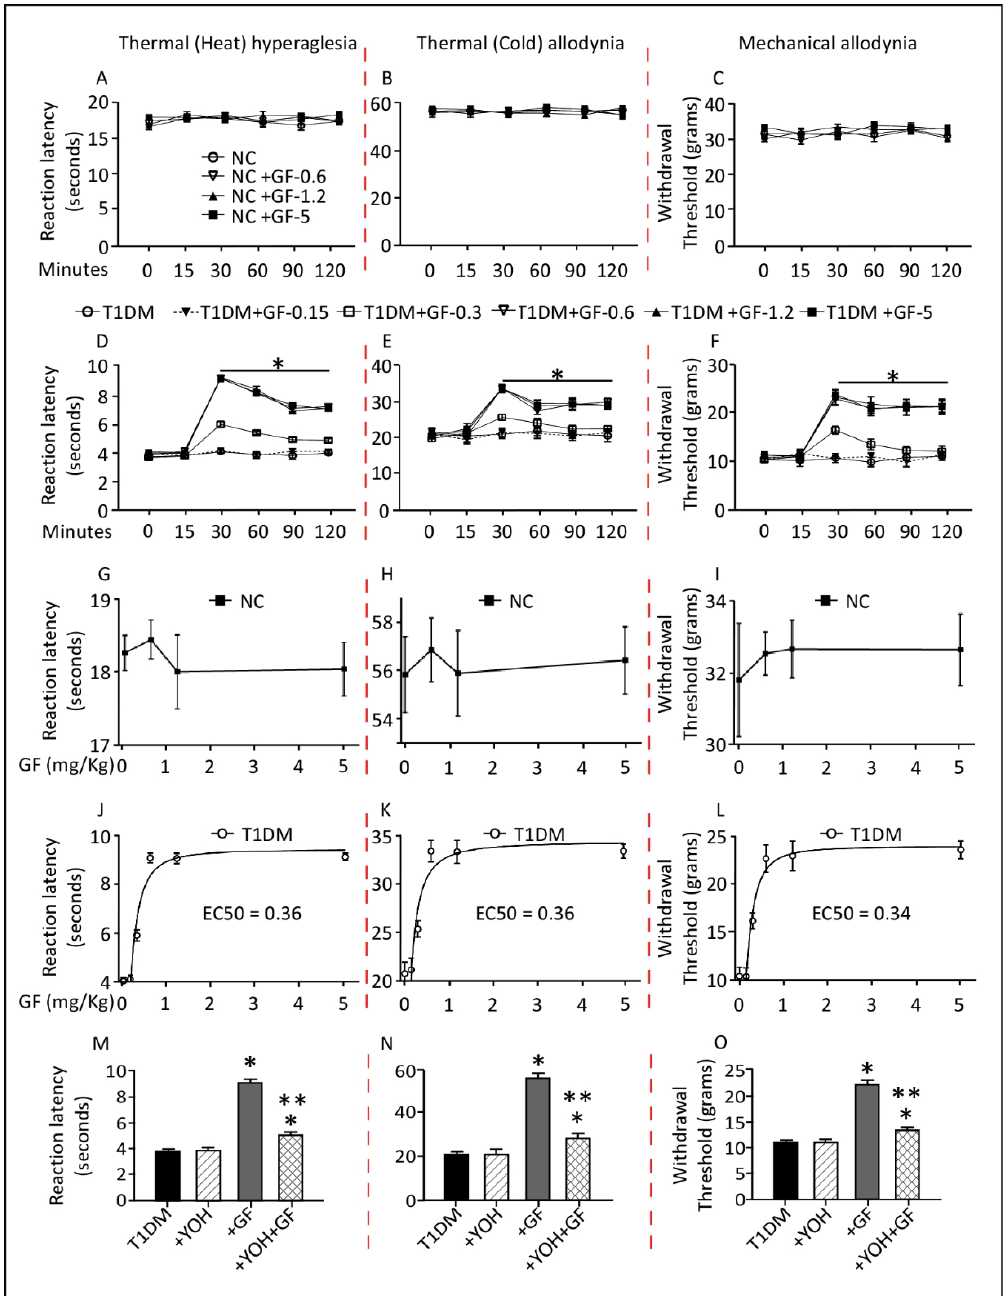
Figure 2. Time and dose response curves of administered guanfacine in control and diabetic rats. Guanfacine dose ‐ dependently elevated thermal (heat/cold) and mechanical threshold ( D – F ) in dia ‐ betic but not in control ( A – C ) rats. Guanfacine in a concentration ‐ dependent manner elevated pain threshold in diabetic ( J – L ) but not in control ( G – I ) rats at the 30 min time ‐ point following admin ‐ istration. Yohimbine antagonizes guanfacine’s analgesic effects ( M – O ). Data are expressed as means ± SEM obtained from five animals/group. * Significantly different from corresponding diabetic val ‐ ues at p ≤ 0.05. ** Significantly different from corresponding guanfacine values at p ≤ 0.05. Abbrevi ‐ ations: NC, Normal Control; T1DM, Type 1 Diabetes Mellitus; YOH, yohimbine; GF, guanfacine; EC, effective concentration.